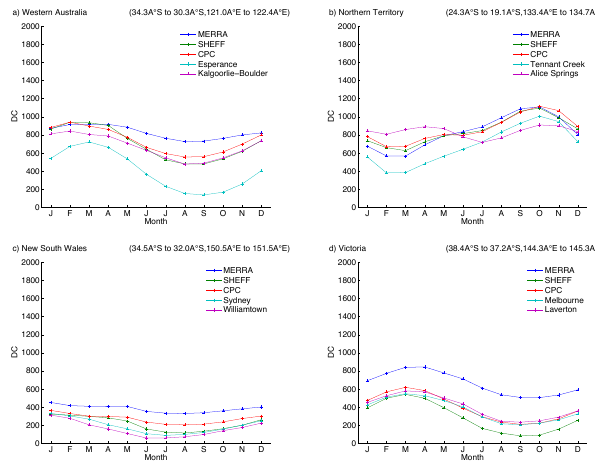
Figure 7. Monthly mean DC for two regions in each of Malaysia and Indonesia. MERRA, SHEFF and CPC DC are from the GFWED gridded fields over the latitude and longitude range spec- ified in the caption. The other two DC plots are for representative weather stations in that range.